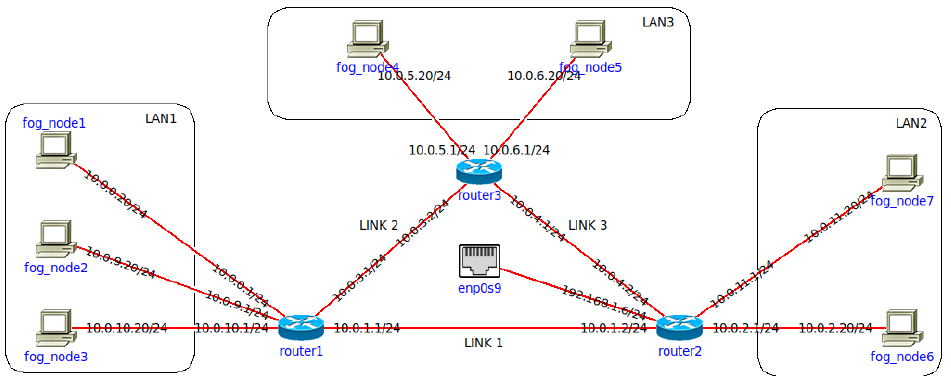
Figure 5. Simulation architecture in